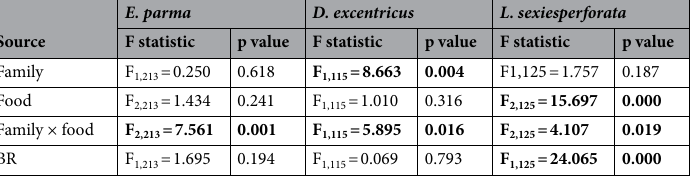
Table 1. Two-factor ANCOVAs with body rod (BR) as a covariate for irregular urchins. Significant values are